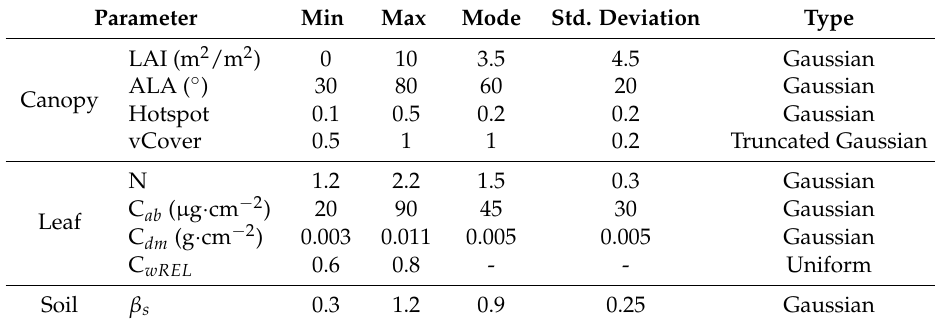
Table 1. Distribution of the parameters within the PROSAIL RTM at canopy (leaf area index (LAI), leaf angle inclination (ALA), hot-spot parameter (hotspot) and vegetation cover (vCover)) and leaf (mesophyll structural parameter (N), leaf chlorophyll (C ab ), dry matter (C m ) and relative water (C w ) contents) levels and the soil brightness parameter ( β s ). Parameter Min Max Mode Std. Deviation